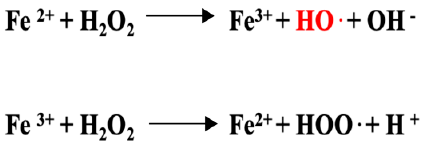
Figure 6. Fenton reaction uses the hydrogen peroxide and catalytic ferrous (Fe 2+ ) ion to produce the hydroxyl radical. Luteolin exerts the metal (Fe 2+ ) chelating capability, avoiding the formation of OH · , the most dangerous ROS for cells. H 2 O 2 = hydrogen peroxide, OH · = hydroxyl radical, OH − = hydroxyl, HOO · = hydroperoxyl, H + = proton.